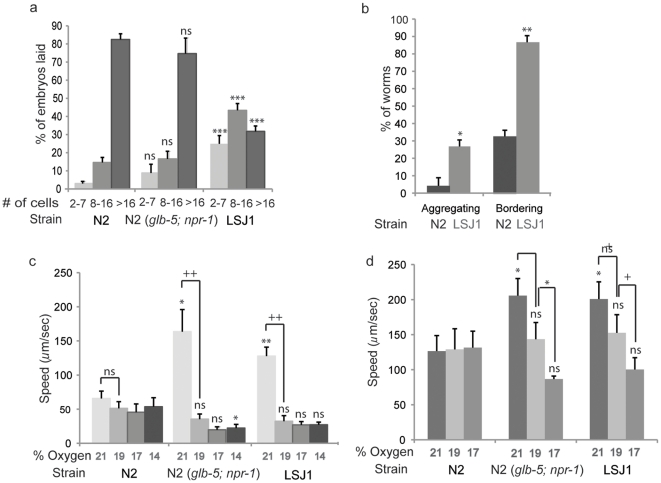
N2 and LSJ1 show behavioral variation.(a) Variation in egg laying (n = 25 for both strains). Egg laying results were fitted to a binomial model and assessed with an ANOVA (2 degrees of freedom, F = 71.05, P = 2.2×10−15). Significances of differences in egg laying were assessed using a Mann-Whitney test with a posthoc Bonferroni correction. (b) Variation in aggregation and bordering behaviors (n = 116 for N2, n = 121 for LSJ1). (c) Variation in oxygen responses on food (n = 30 for both strains). (d) Variation in oxygen response off food (n = 40 for LSJ1, n = 30 for N2). In all panels, asterisks indicate significances of differences from N2 under identical conditions, while plusses indicate significance of speed alteration within strains in response to oxygen changes; ns = not significant, */+ indicates p<0.01, **/++ indicates p<0.001, and *** indicates p<0.0001; error bars indicate s.e.m.